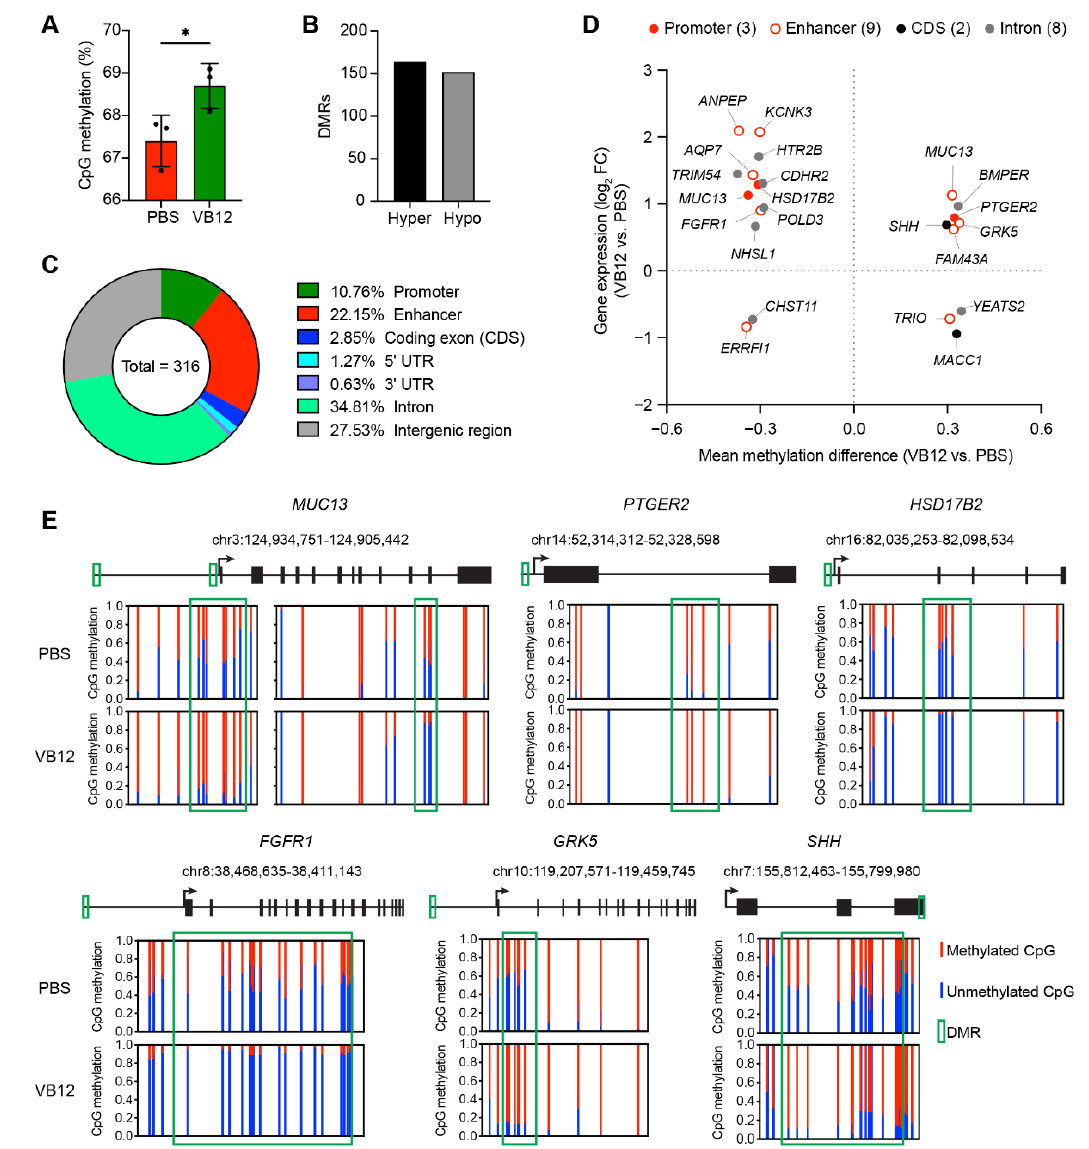
Figure 4. VB12-mediated alterations in genome-wide DNA methylation profiles of human iECs. ( A ) Global CpG methylation ratios of human iECs cultured with VB12 or PBS for 2 weeks (n = 3 samples/group). ( B ) Summary of the number of differential methylation regions (DMRs) between VB12- and PBS-cultured human iECs from WGBS analysis. ( C ) Donut chart representative of the DMR genomic distribution. UTR, untranslated region. ( D ) Comparison of DEGs and DMRs between VB12 and PBS groups. The number of DMRs within indicated locations of the DEGs is shown in parentheses. ( E ) Normalized plots of CpG methylation at sites surrounding or within DMRs of genes associated with barrier function ( MUC13 ) and cell proliferation ( PTGER2 , FGFR1 , GRK5 and SHH ) obtained from WGBS analysis. The red and blue lines depict methylated and unmethylated CpG sites, respectively. * p < 0.05; two-tailed unpaired t -test ( A